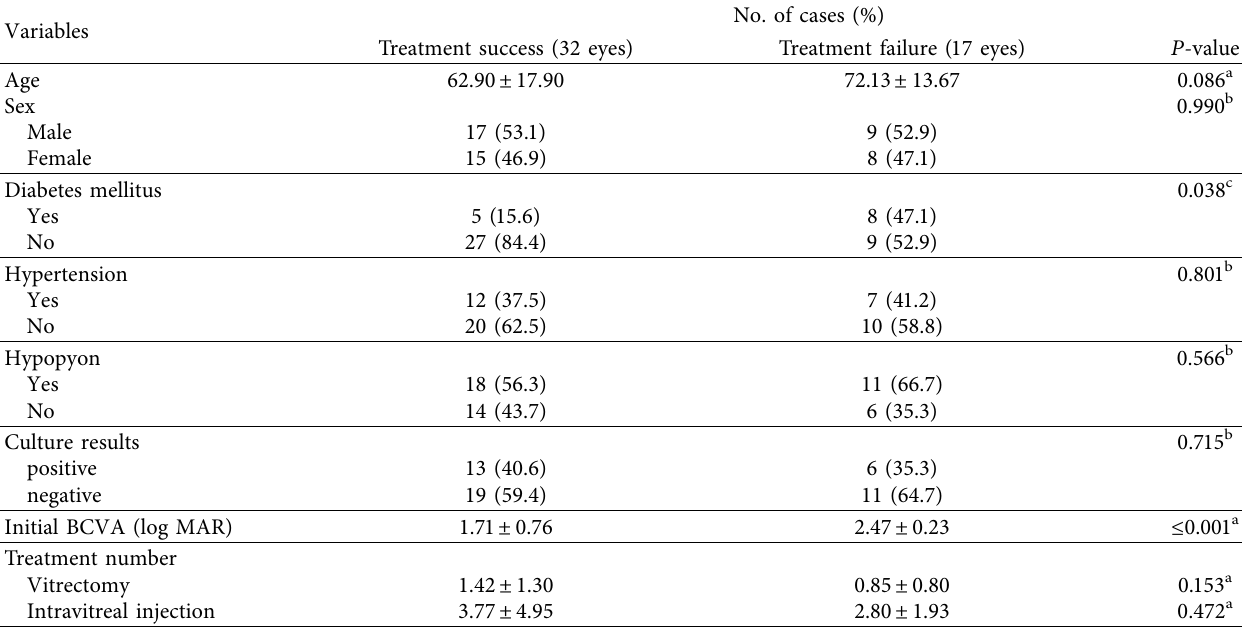
Figure 3: The average temperature, the annual precipitation, the average humidity, and the annual sunshine hours for 10 years (2009–2018) in South Korea. The graph showed that Jeju Island had the highest average temperature (1 st place), the highest annual precipitation (1 st place), higher average relative humidity (4 th place), and the lowest annual sunshine hours (1 st place) for 10 years in the country. Table 4: The comparison between treatment success and treatment failure